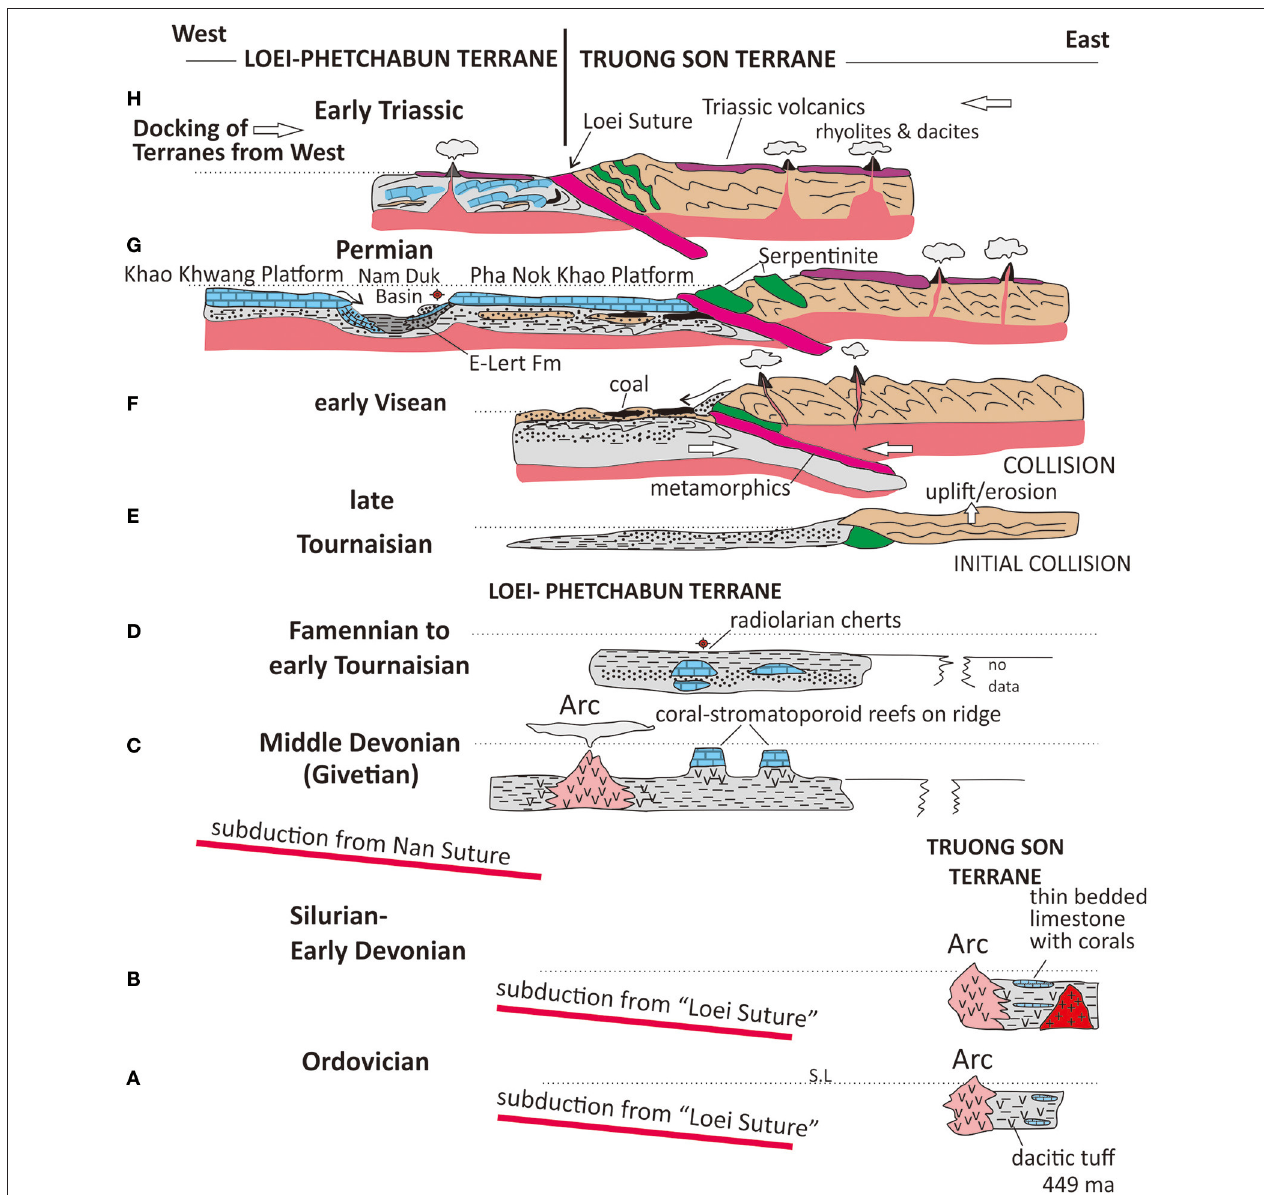
FIGURE 14 | Diagrammatic reconstructions, not to scale, showing the development of the Loei-Phetchabun and Truong Son terranes in northeast Thailand in Loei, Nong Khai, and Udon Thani provinces (south of Mekong River) and in an immediately adjacent part of Laos along and just north of the Mekong River. Line of section is shown in Figure 1 . Fold vergence based on Chairangsee et al. (1990). Cardinal directions are present-day. In this area, the orogenic belt known as the Loei Foldbelt (Loei in Figure 1 ) is divided into a western Loei-Phetchabun Terrane and an eastern Truong Son Terrane (East Loei on Figure 1 ) separated by the Loei Suture. (A) Ordovician in Truong Son Terrane in Laos based on Long et al. (2019). (B) Silurian to Early Devonian. Truong Son Terrane in Thailand and Laos. Thin fossiliferous limestones interbedded with shales and volcaniclastics interdigitate westwards with a volcanic island arc formed by eastward subduction of oceanic lithosphere. (C) Late Devonian (Givetian- Frasnian). Arc volcanism in central Loei Foldbelt (Panjasawatwong et al., 2006) with north-south ridges to the east in the Givetian with highly fossiliferous coral-stromatoporoid reefs overlying thin bedded limestones which overlie siliciclastics with plant material, trilobites, large brachiopods, and other benthos (Udchachon et al., 2017). (D) Famennian to earliest Tournaisian. Radiolarian cherts were deposited over much or most of the area (Saesaengseerung et al., 2007; Burrett et al., 2015). (E) Tournaisian. Initial docking of the Loei-Phetchabun and Truong Son terranes led to uplift of the over-riding block in the east and the deposition of a mainly turbiditic sequence of siliciclastics containing rare plant fragments in the west (Chairangsee et al., 1990). (F) Early Visean. Continued collision led to uplift of the over-riding block, metamorphism in the footwall area and the deformation of ophiolites in the Loei Suture and serpentinised ultramafics were squeezed close to the surface. Volcanism in the east provided volcanic material to coal deposits deposited further west. Other terrestrial deposits are evaporites and sandstones. (G) Early Permian. Continued erosion of the orogen led to the development of carbonate platforms during the mid-Visean separated by deeper marine basins such as the Nam Duk Basin. Deep-water siliciclastic and limestone turbidites in the Nam Duk Basin contain mafic detritus from the eroded Loei Suture to the